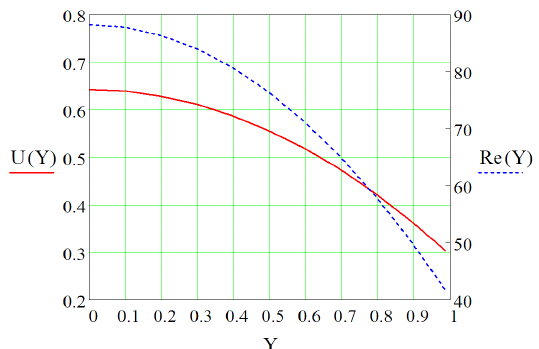
Figure 12. Velocity distribution U(Y) and Reynolds number Re(Y) for refrigerant circulation in rectangular microchannels as a function of path travelled (dimensionless values).